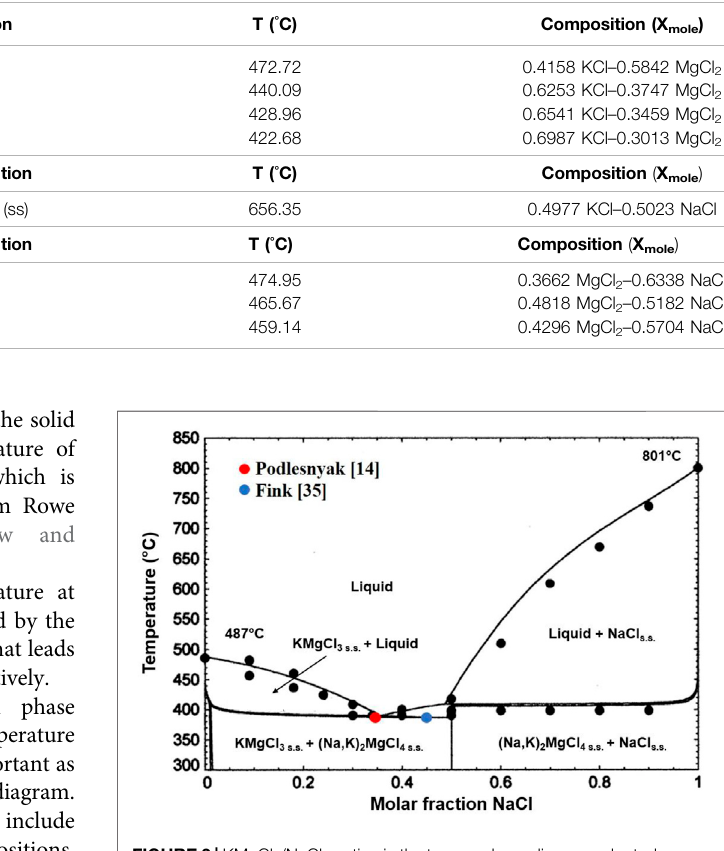
FIGURE 3 | KMgCl 3 /NaCl section in the ternary phase diagram adapted from the study by Chartrand et al. (Chartrand and Pelton, 2001). Two experimental points from the study by Podlesnyak et al. (Podlesnyak et al., 1987) and Fink et al. (Fink and Seifert, 1984) are added to verify this phase